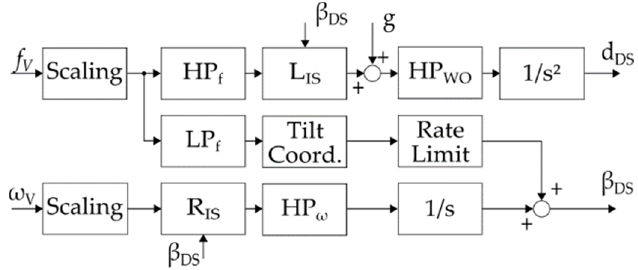
Figure 1. Classical washout algorithm, based on [3] (p. 29).